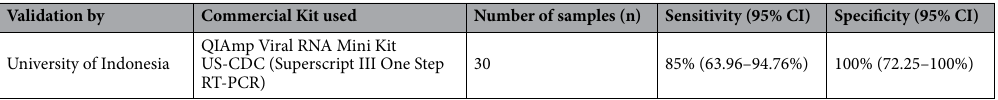
Table 3. Validation of gargle specimens with other commercial RNA extraction kits and qRT-PCR kits.